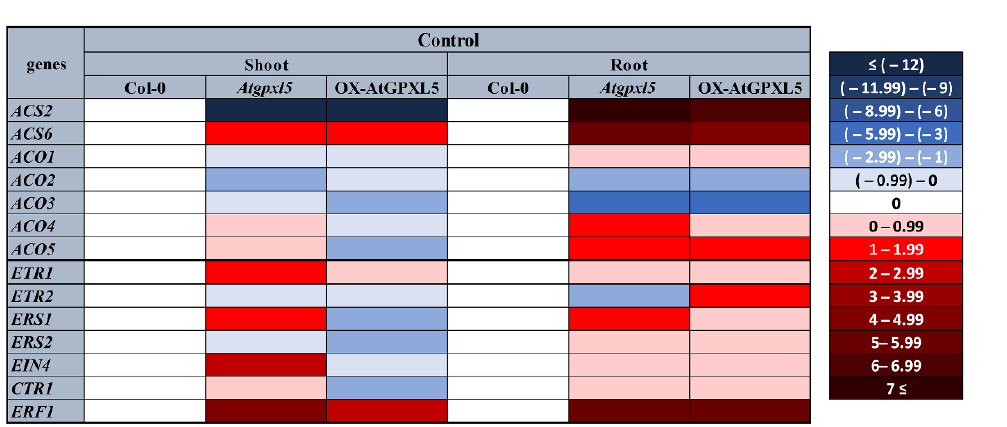
Figure 2. Relative expression of genes related to ET biosynthesis and signalling, such as ACS2 , ACS6 , ACO1 , ACO2 , ACO3 , ACO4 , ACO5 and ETR1 , ETR2 , ERS1 , ERS2 , EIN4 , CTR1 , ERF1 , in the shoots and roots of 6-week-old Arabidopsis thaliana wild type (Col-0), Atgpxl5-1 insertional mutant ( Atgpxl5 ) and AtGPXL5-overexpressor (OX-AtGPXL5) plants. The actin2 (At3g18780) gene was used as internal control, data were normalised to the control wild-type values (1) and presented on a log2-scale as a heatmap. Red colours show activation, while blue colours show repression, according to the colour scale bar. The mean 2 (−ΔΔCt) data of RT-qPCR analysis are shown in Supplementary Table S1; n = 3. Abbreviations: ACO — ACC oxidase; ACS — ACC synthase; CTR — constitutive triple